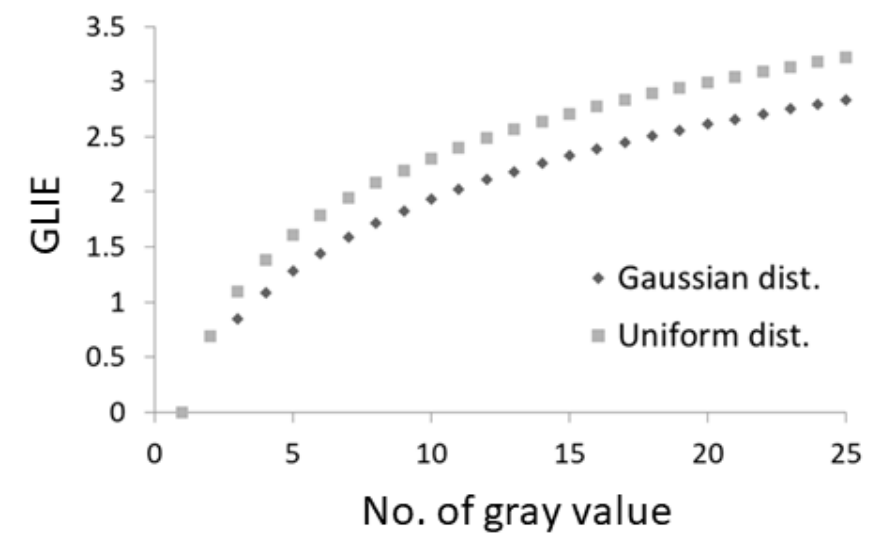
Figure 3. Gray Level Information Entropy (GLIE) values in a 5 × 5 pixel unit according to the number of gray levels in that unit. GLIE values were calculated based on a uniform distribution of the different gray levels in the 25-pixel unit or according to a Gaussian distribution of the different gray levels in that unit.